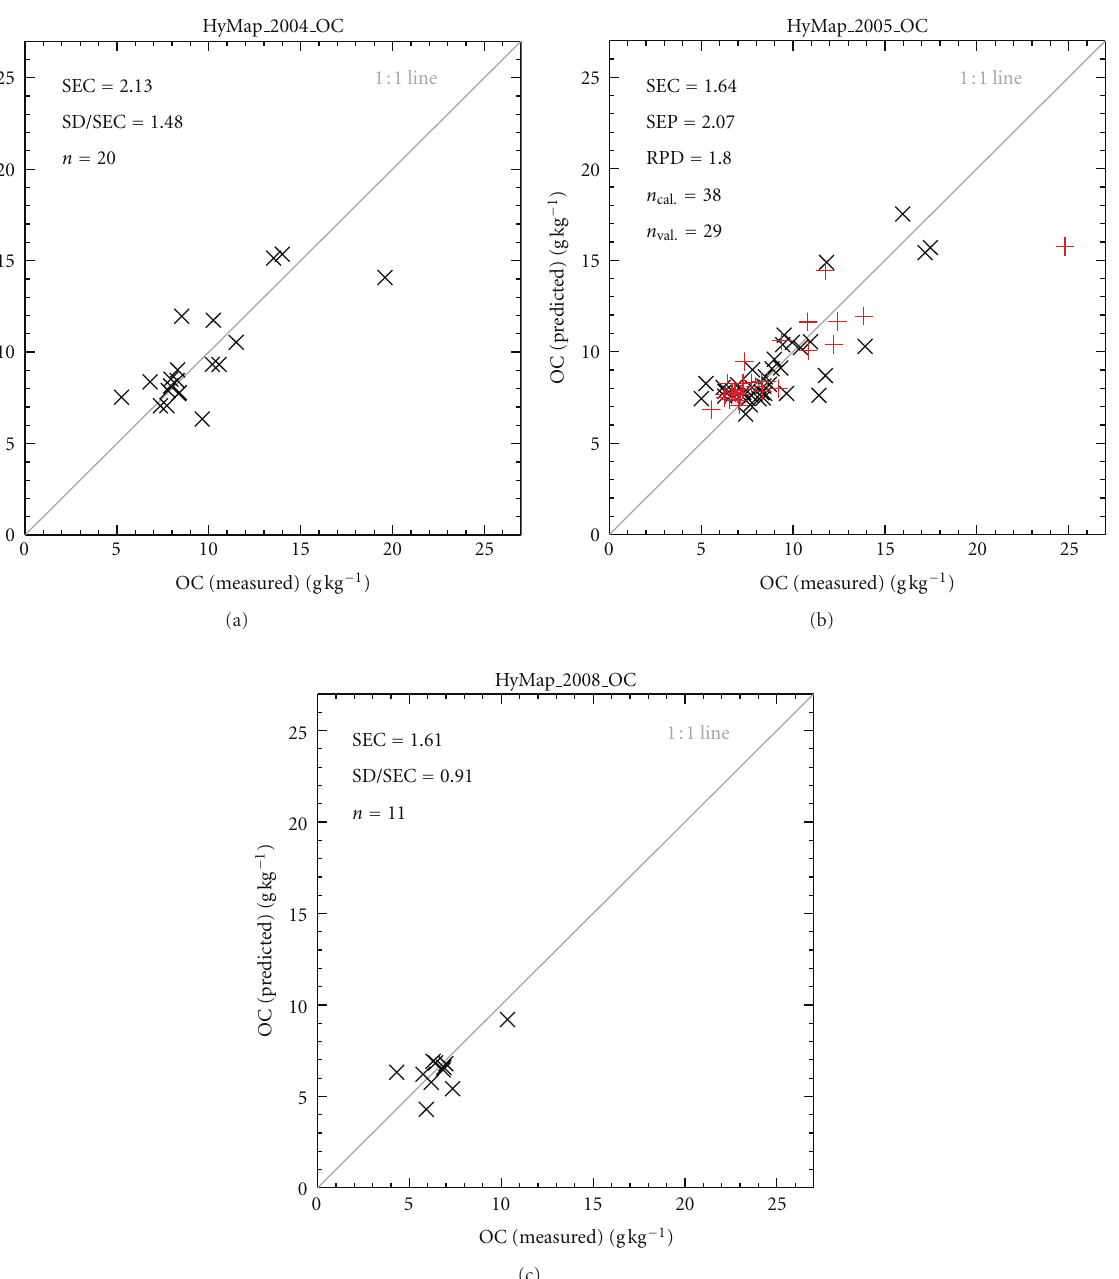
Figure 11: Plots of measured versus predicted values for organic carbon (g kg − 1 ) in the calibration (black symbol, × ) and validation (red symbol, +) data sets based on HyMap image spectra. The respective calibration and validation data schemes ( n cal . / n val . ) are marked on the plots. For further explanation see